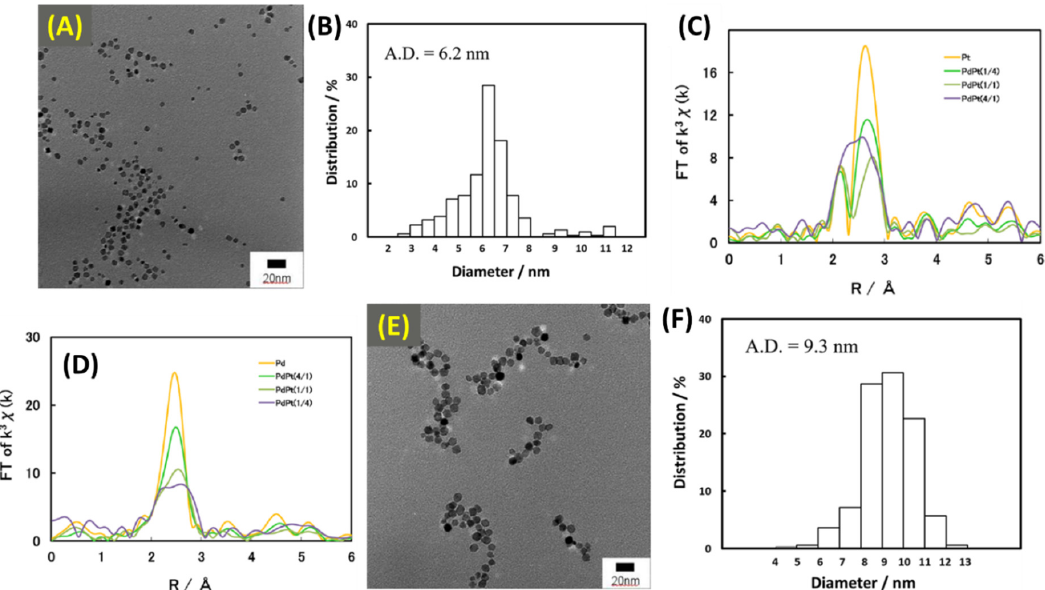
Figure 25. ( A ) TEM images for Pd/Pt (1/1) NPs synthesized using multimode µwH in EG, corresponding size distribution analysis is shown in ( B ), ( C ) shows FT-EXAFS spectra; ( D – F ) show TEM, size distribution analysis, and FT-EXAFS spectra respectively for Pd/Pt (1/1) NPs synthesized using multimode µwH in glycerol. Copyright 2018 American Chemical Society.